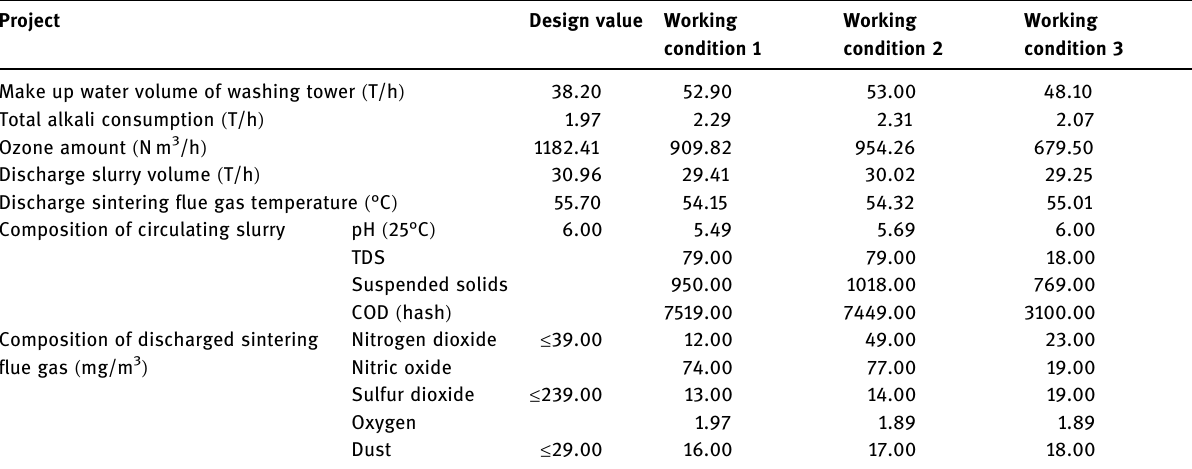
Table 2: Main process parameters of washing tower unit